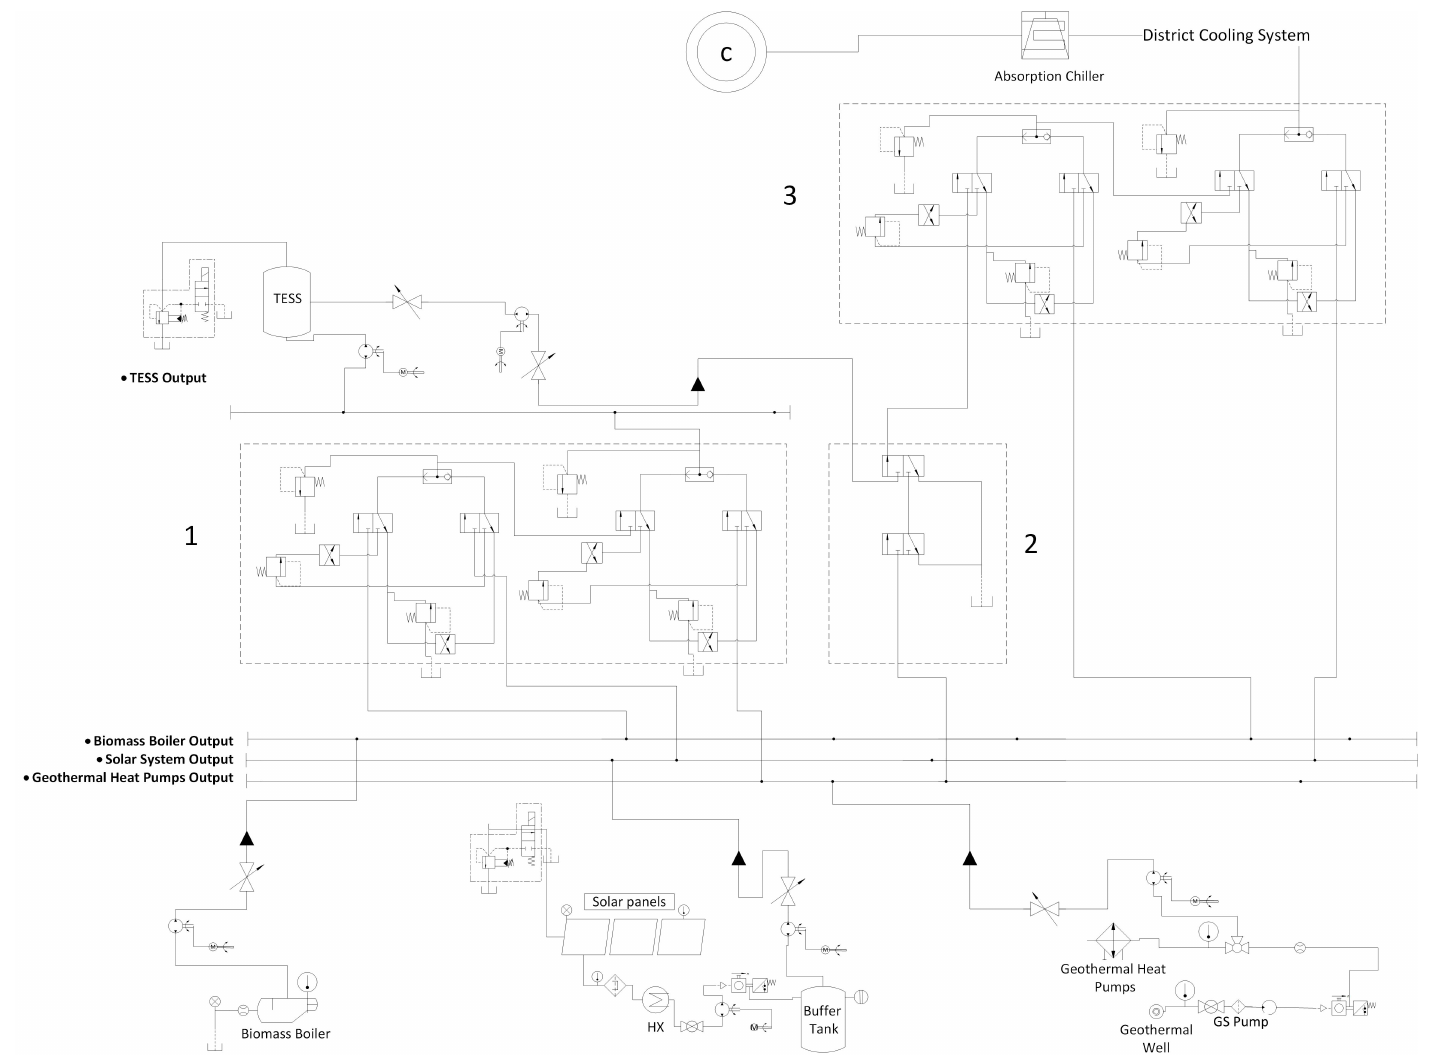
Figure 10. Proposed superstructure to cover the cooling needs of the case